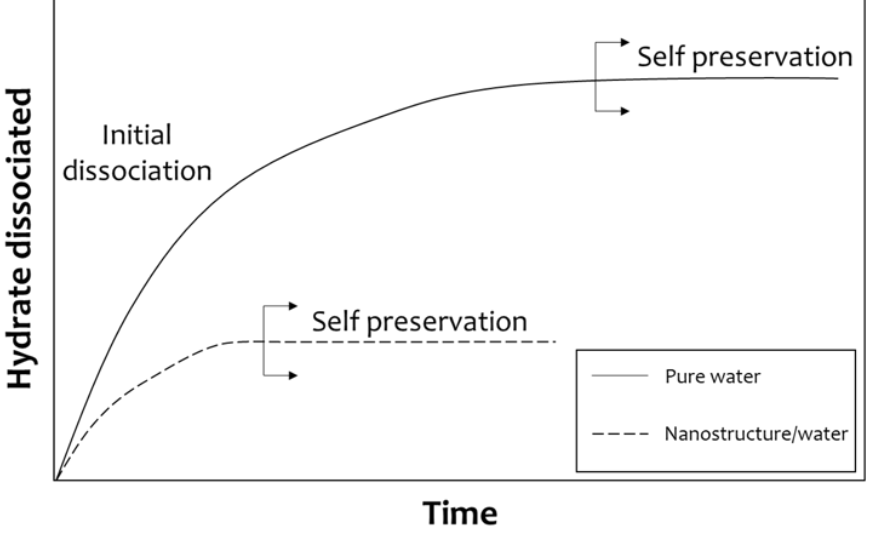
Figure 3. The typical trend of hydrate dissociation versus time. Nanostructure promoters are expected to increase the stability while decreasing the time needed to reach